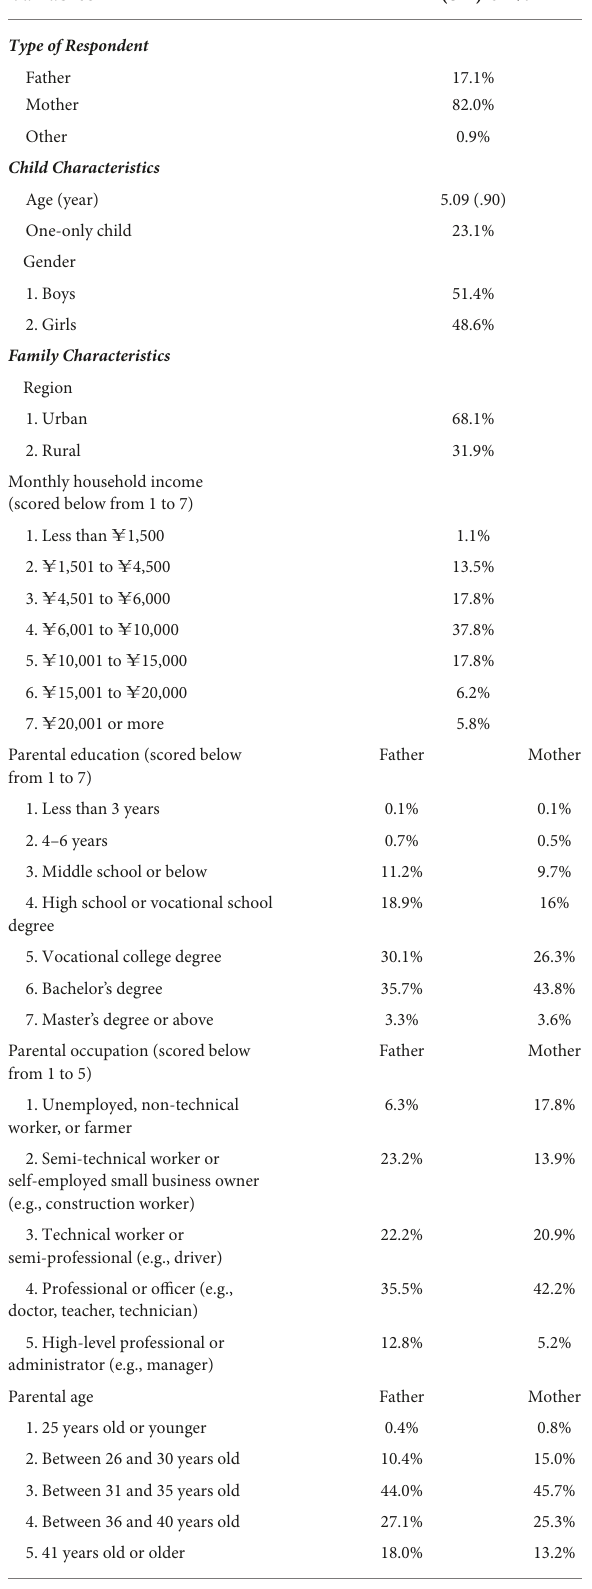
TABLE 1 Demographic information of the sample ( n =